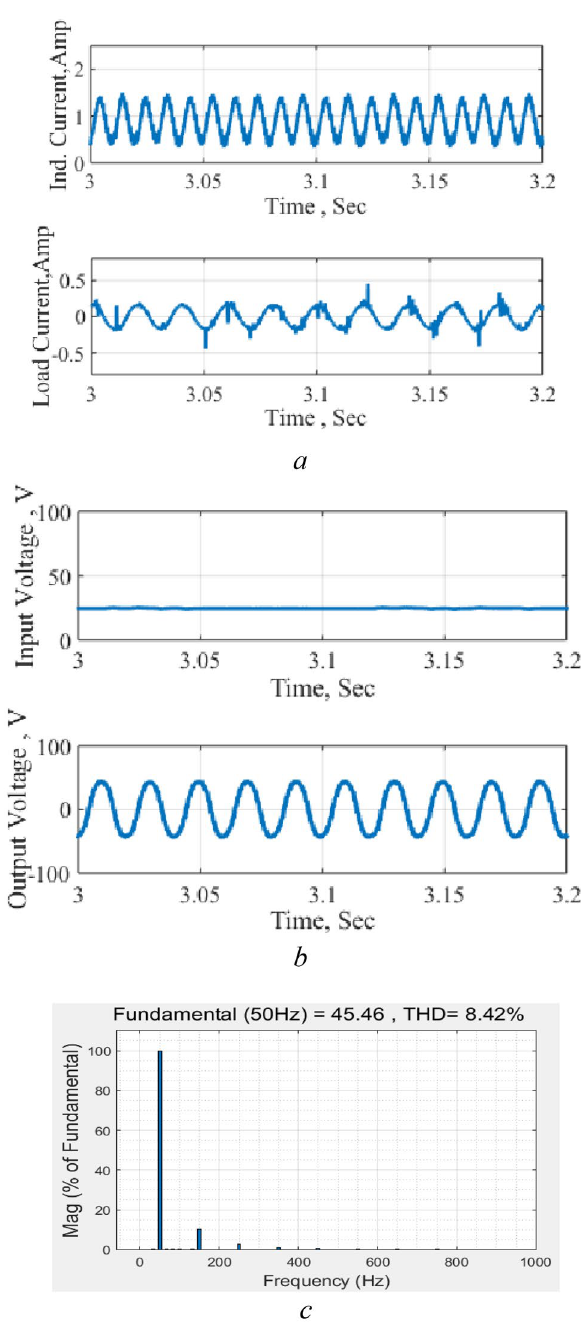
Figure 16. Circuit performance as an inverter. ( a ) Inductor and output current, ( b ) input and output voltages, ( c ) THD